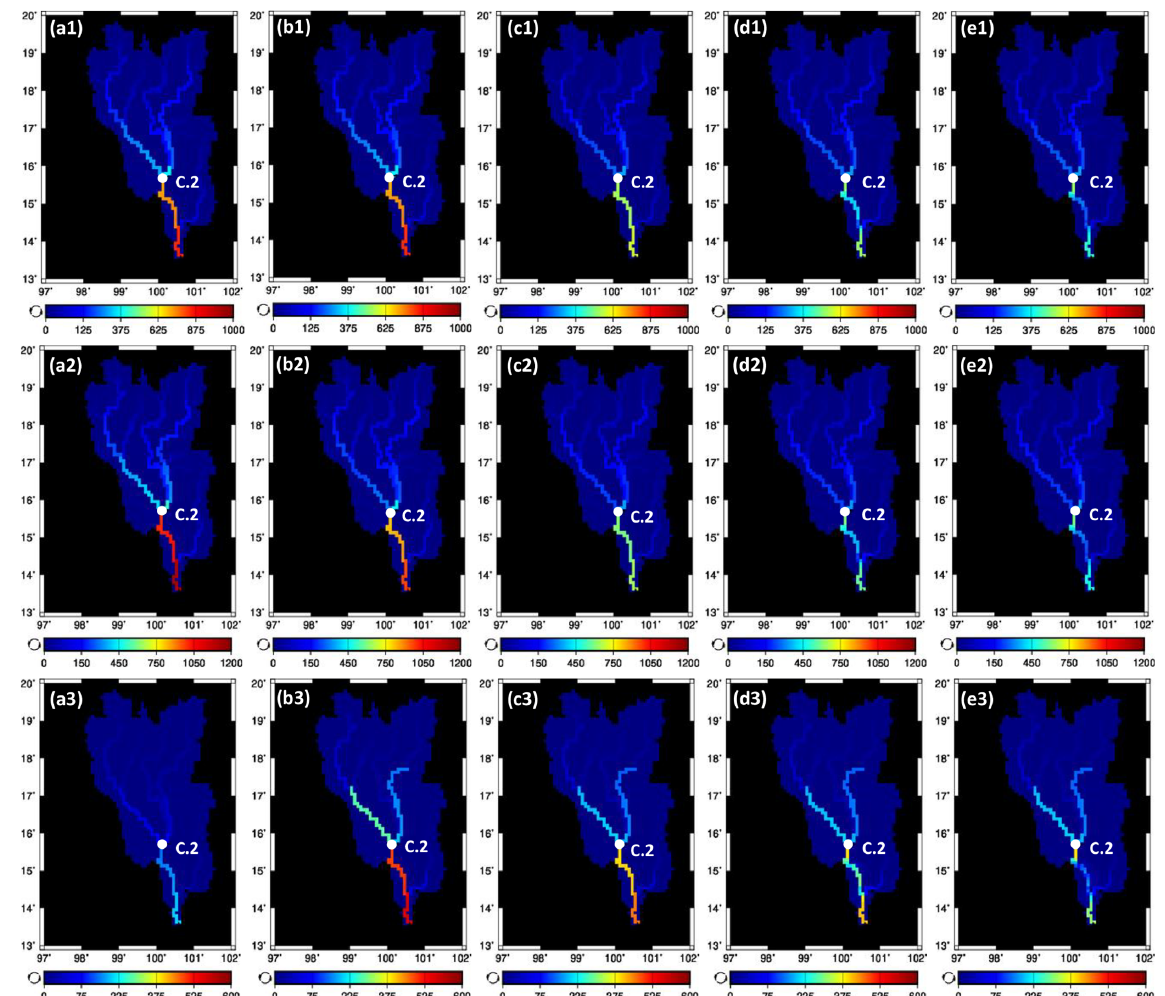
Figure 7. Effect of canal systems on annual average (top panel), wet season (middle panel), and dry season (bottom panel) discharges in the